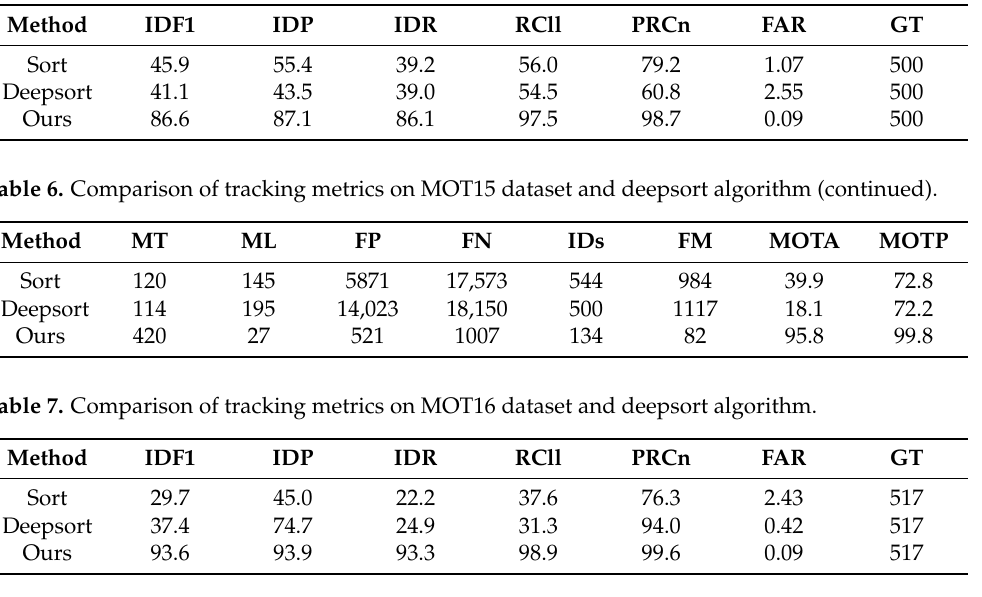
Table 5. Comparison of tracking metrics on MOT15 dataset and deepsort algorithm.